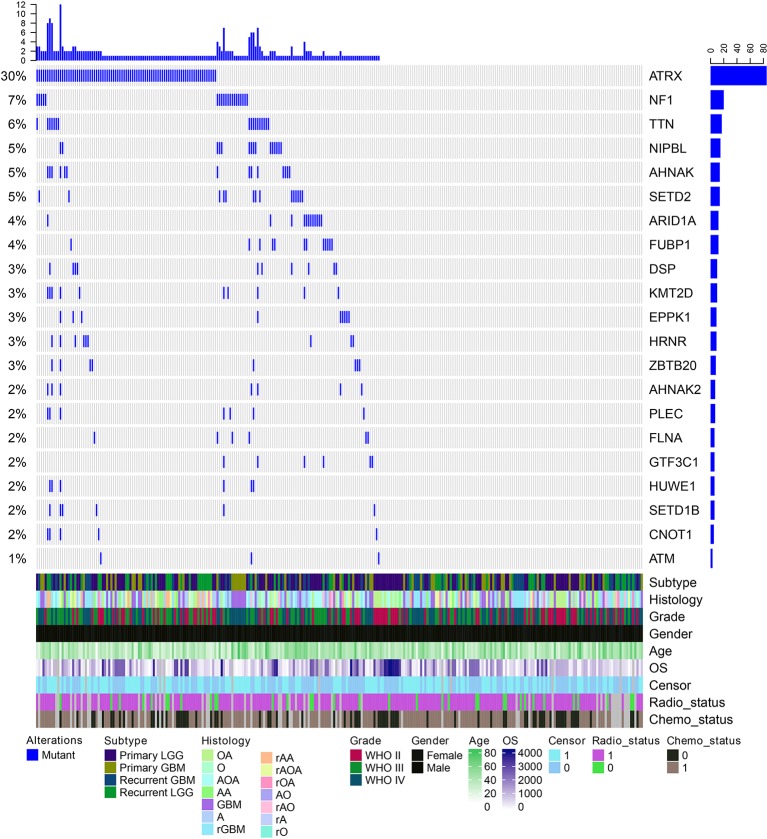
The mutation spectrum of top ranked RNA-binding proteins (RBPs) in glioma. Each column is one glioma patient. The blue lines indicate whether the gene is mutated or not. The clinical information of these patients are shown on the bottom panels.